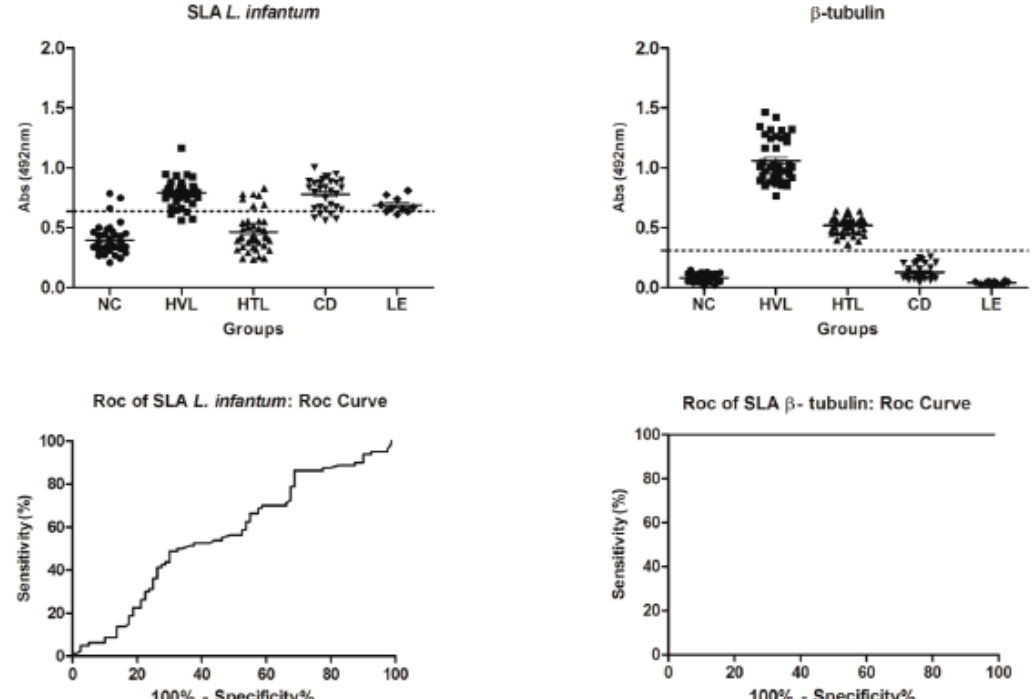
Figure 5. Three-dimensional analysis of the interaction between antibodies and targeted protein. Results ( A , B ) showing the regions of interaction between the scFv E8 (gray) and β -tubulin (orange) are shown, as well as structures from CDR regions of the scFv antibodies associated to β -tubulin protein are shown.